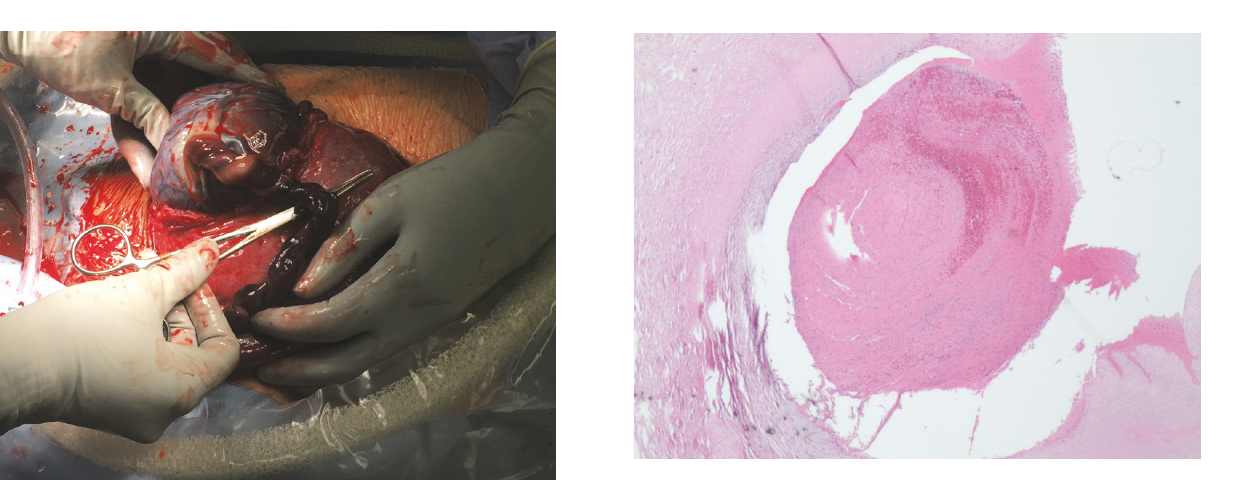
Figure 2: Cross section of umbilical vein with 40% thrombus occluding the vessel.